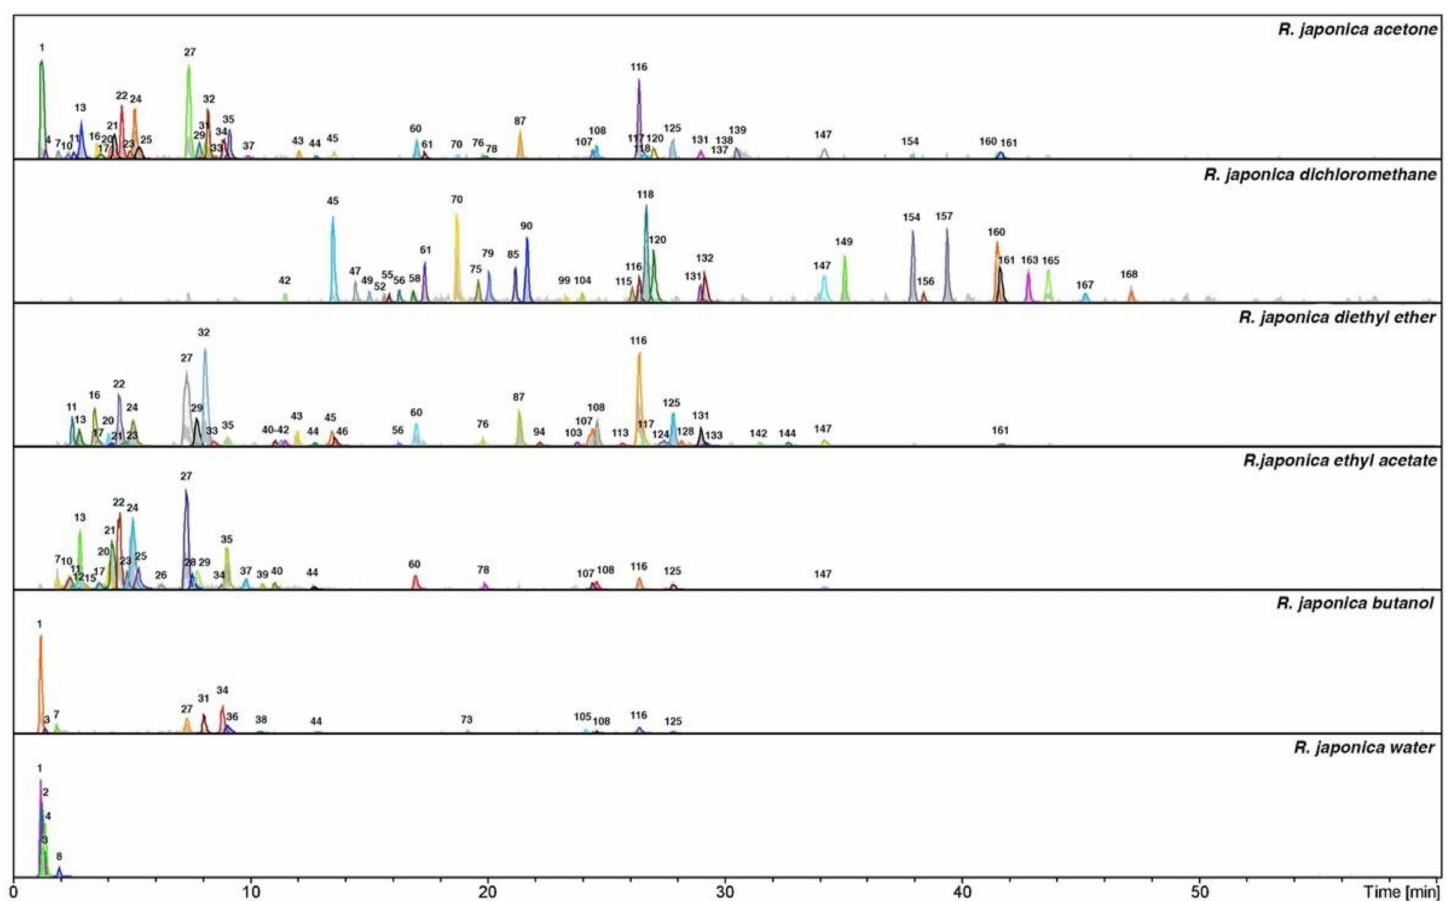
Figure 1. Total ion chromatograms in negative ionization mode and dissect chromatograms of Reynoutria japonica extract and fractions. Deconvolution of an LC/MS mass chromatogram was carried out by using the Bruker’s Dissect algorithm. Peak numbers are explained in Table